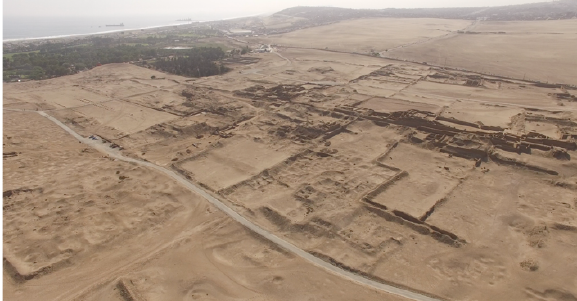
Figure 2 . Aerial view of the site (© A. Van Dongen)